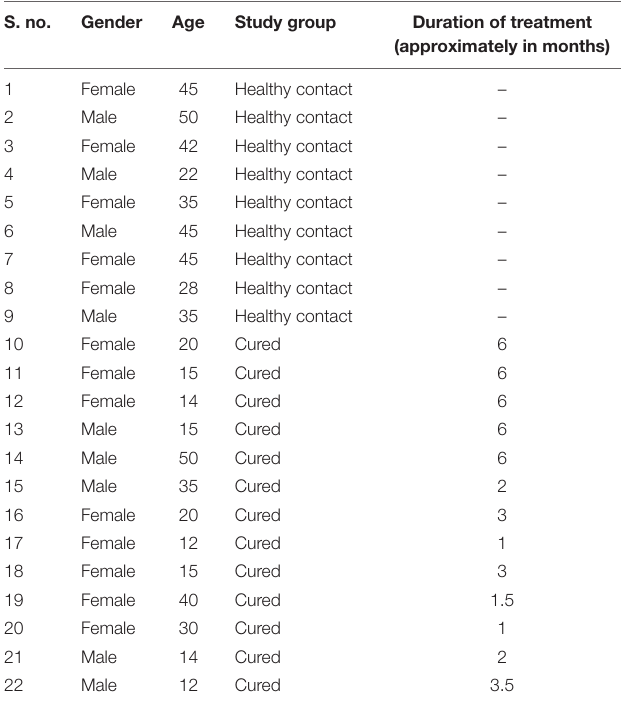
TABLE 2 | Clinical data of treated VL patients and healthy